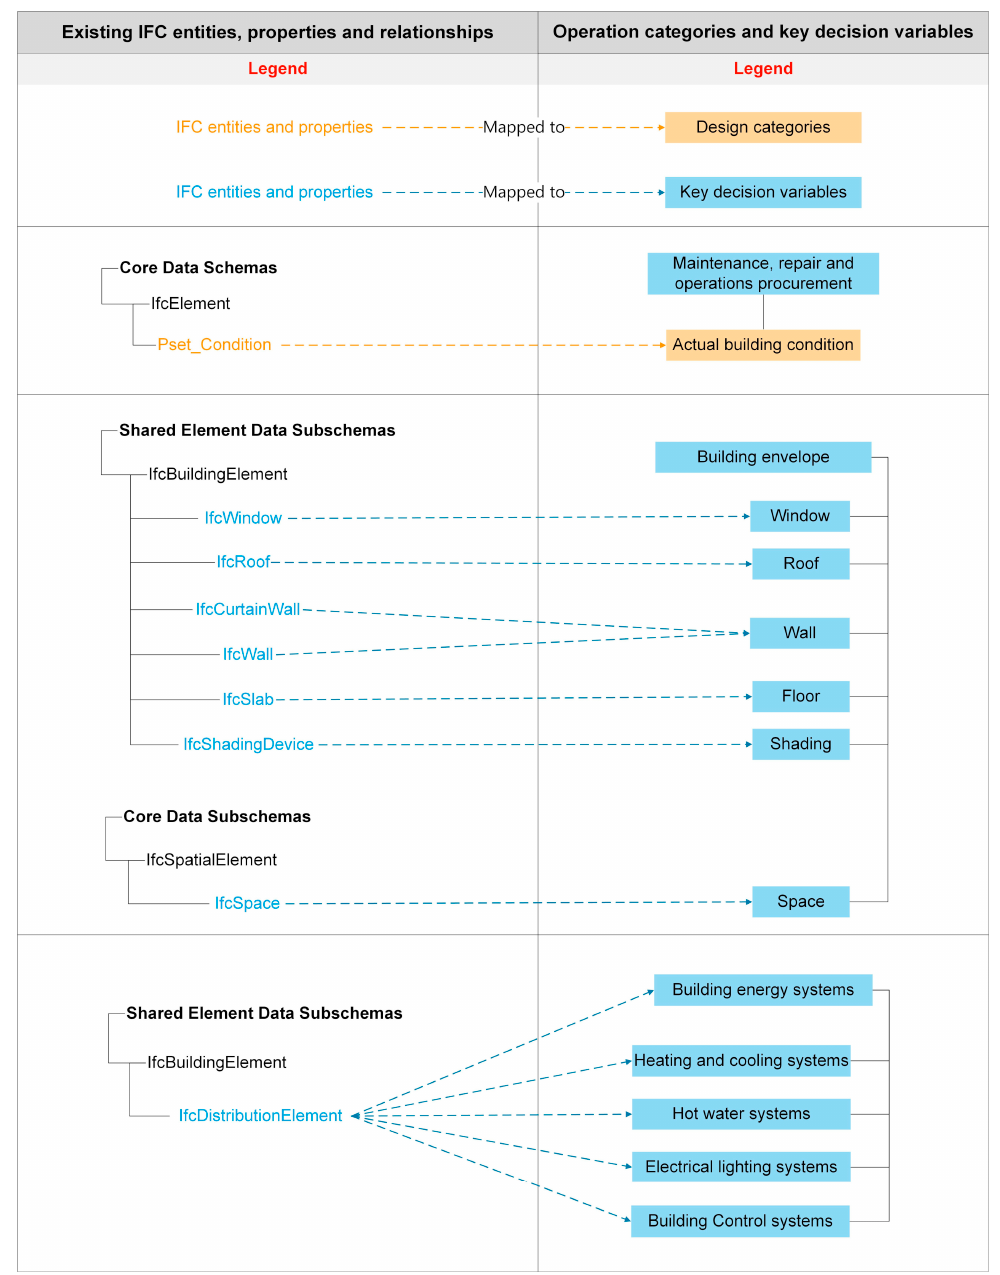
Figure 11. Existing IFC entities, properties, and relationships representing design categories and key decision variables affecting net-zero-carbon building outcomes at operational stage.